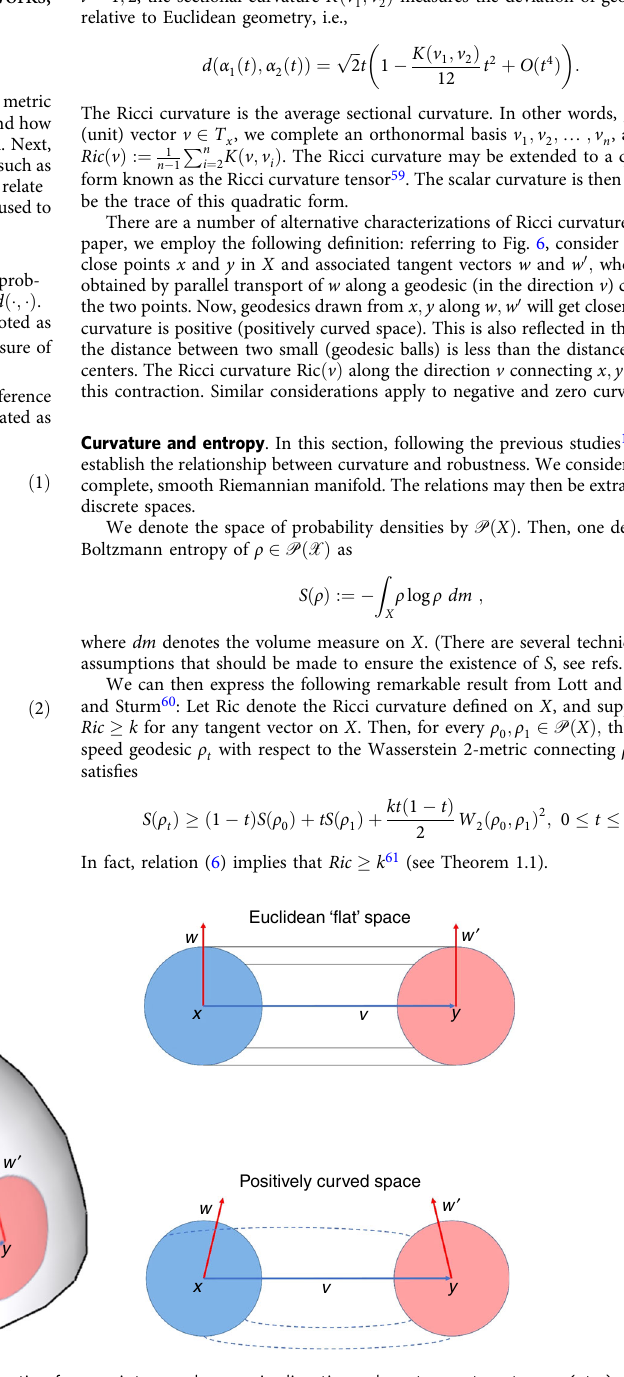
Fig. 6 In a space with positive Ricci curvature, parallel geodesics emanating from points x and y , e.g., in directions along tangent vectors w (at x ) and w 0 (at y ), are drawn closer. In a Euclidean space, the distance between points moving along parallel geodesics at constant speed remains